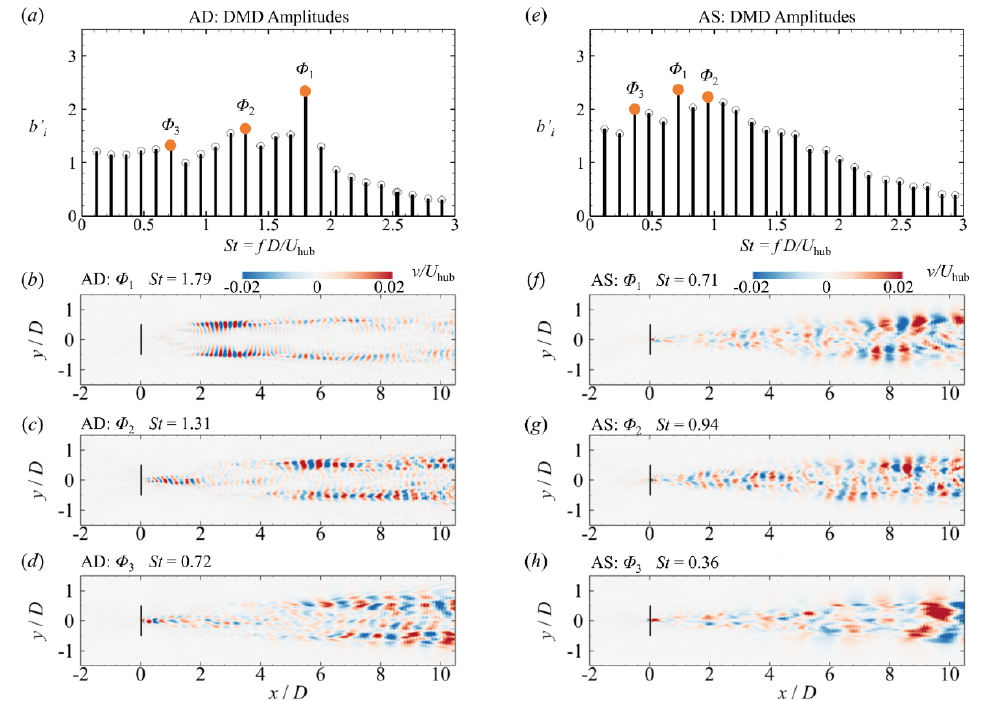
Figure 12. Coherent structure in the wake revealed by dynamic mode decomposition (DMD) behind an AD modeled (left column) and an AS modeled wind turbine (right column). ( a , e ) The eigenvalue- weighted amplitudes of the DMD modes; ( b – d ) the first three principal modes predicted by the AD model; ( f – h ) the first three principal modes predicted by the AS model. Reprinted from Ref. [29] under Creative Commons Attribution